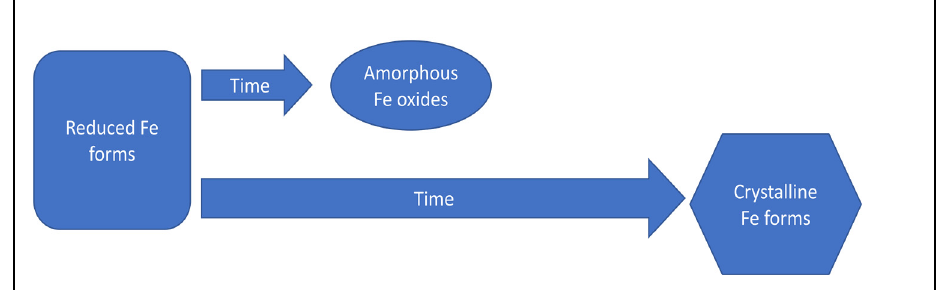
Figure 3. Time-dependent effects of sediment drying on iron chemical